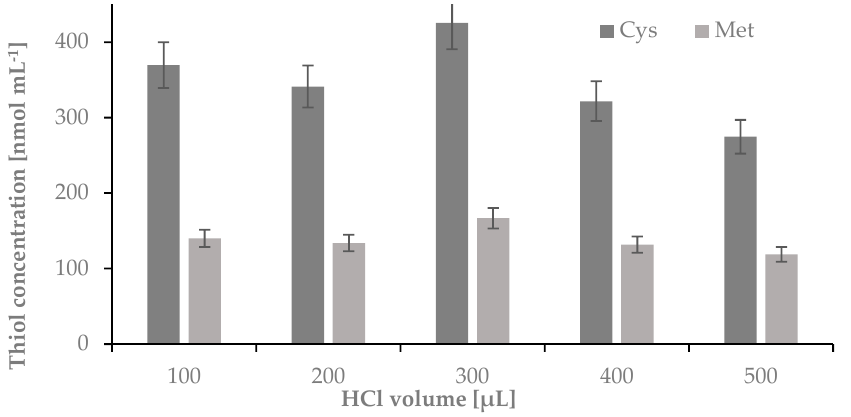
Figure 4. The influence of volume of 6 mol L − 1 HCl on the hydrolysis yield of nail plate samples, measured as signals of cysteine-2-chloro-1-methylquinolinium tetrafluoroborate and methionine- o - phthaldialdehyde-N-acetylcysteine derivatives; n = 3.